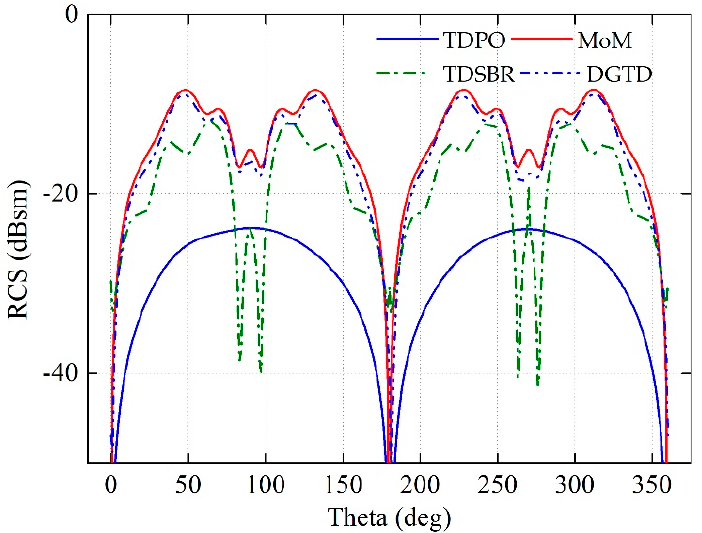
Figure 9. ( a ) The transient scattered electric field of a multi-scale object computed at theta = 0°, phi = 0°. ( b ) The RCS of a PEC object computed from 0.5 to 1GHz (theta = 0°, phi = 0°) from the solu-